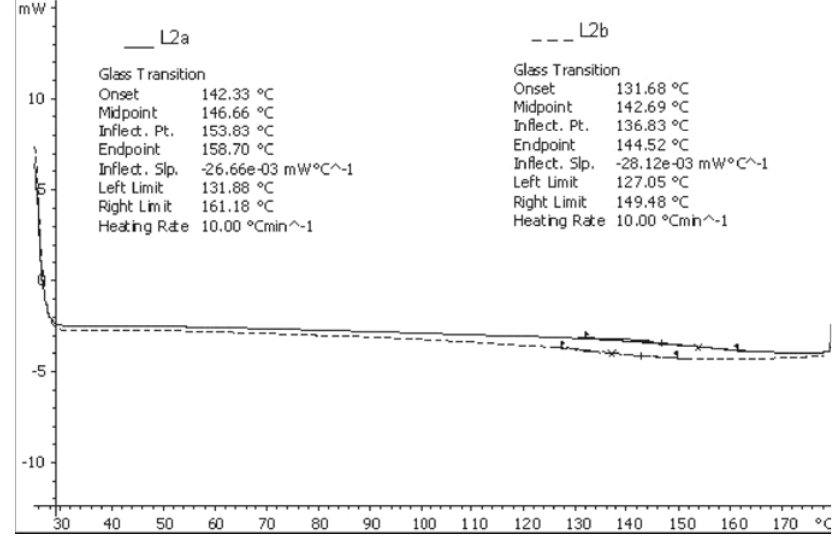
Fig. 4. DSC curves of SE lignin.L2a – oven-dry SE lignin (SE treatment time 2 min);